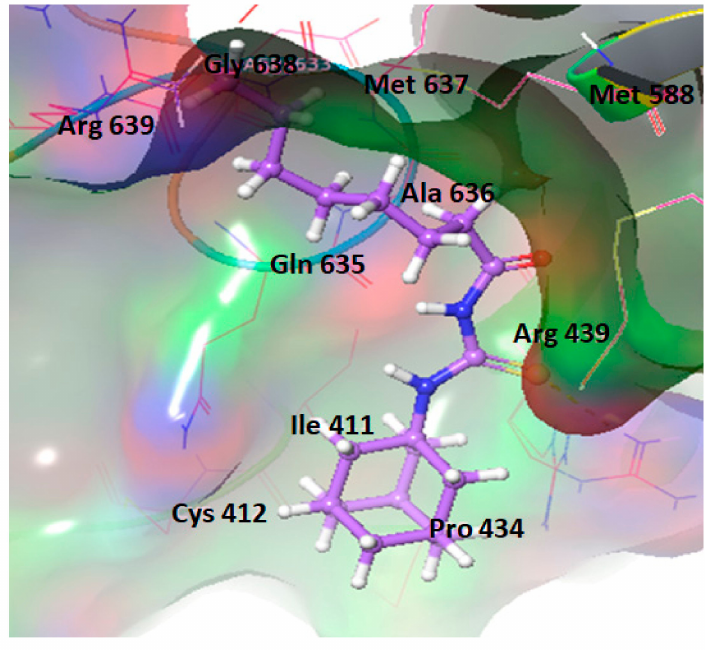
Figure 6. Docking complex of 3j .